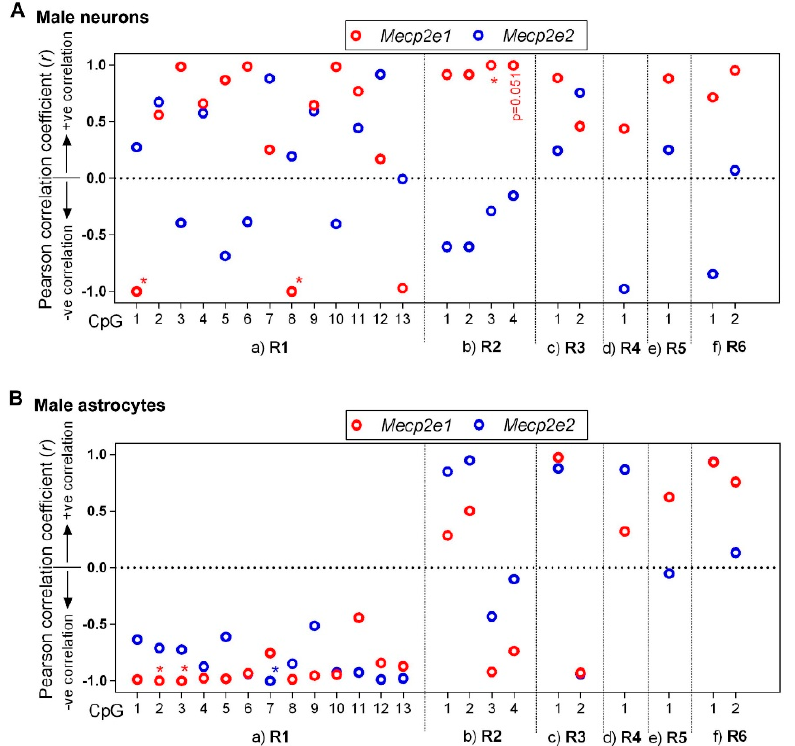
Figure 5. Correlation analyses between DNA methylation at the Mecp2 regulatory elements (REs) and Mecp2 isoform-specific expression in male neurons and male astrocytes. ( A ) Male neurons; ( B ) male astrocytes. All graphs represent the Pearson correlation coefficient ( r ) for Mecp2e1 (red) and Mecp2e2 (blue). Statistical significance of the correlation is indicated by * p < 0.05; N = 3. Individual CpG sites at the promoter regions (a) R1, (b) R2, and (c) R3 and intron 1 regions (d) R4, (e) R5, and (f) R6 are shown on the x -axis.